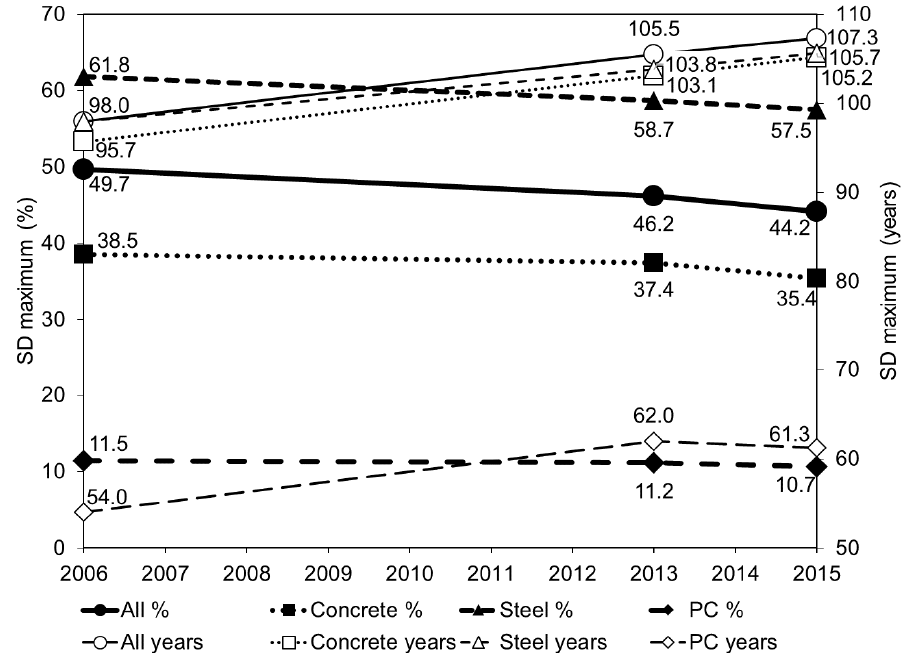
Figure 7. Maximum average accumulation of structural deficiency.